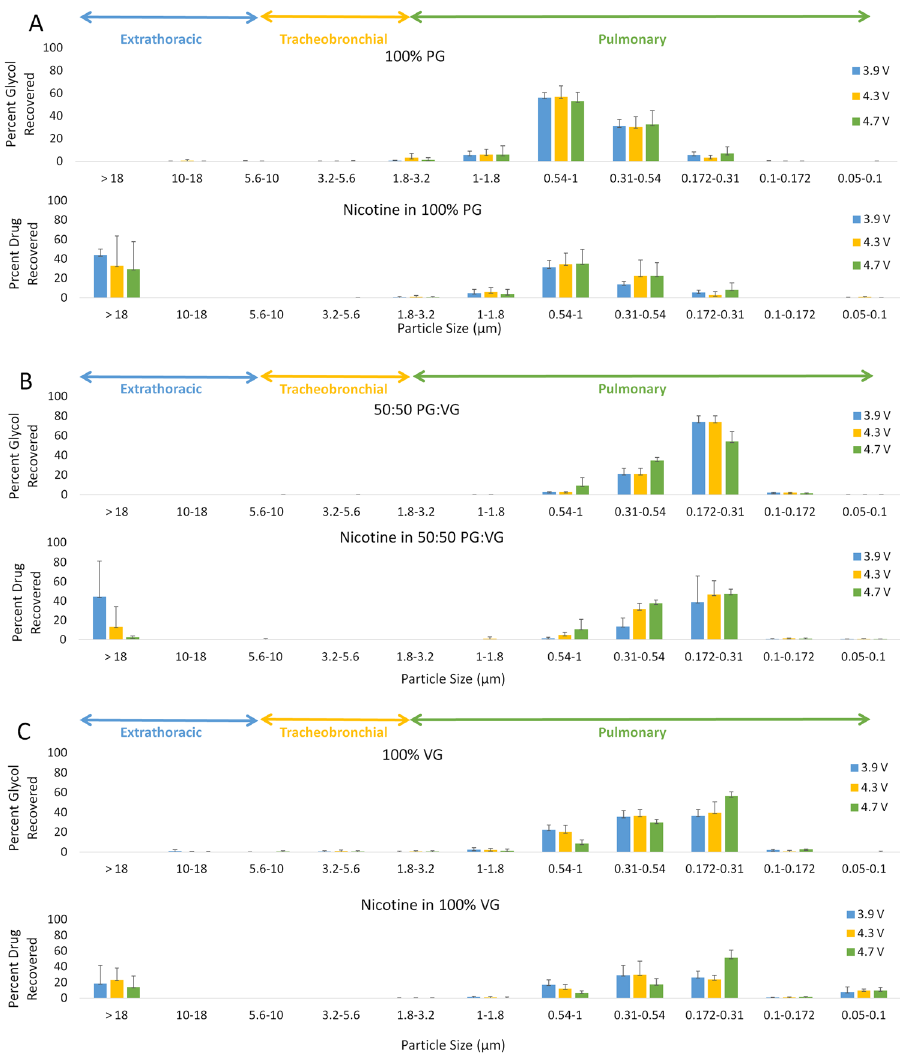
Figure 2. Particle size distribution of glycol and nicotine aerosol by glycol composition and coil resistance at 4.3